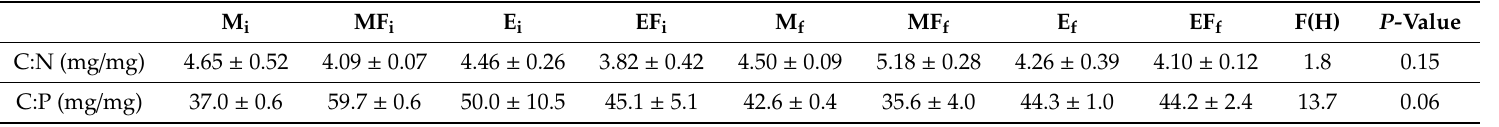
Table 5. Results of one-way ANOVA comparing mean values ( ± SE) of ratios of indicators of nutritive quality of zooplankton in experimental mesocosms: E—eutrophic, LE—low-eutrophic, F—fish, i—initial (June) date, f—final (July) date, C—organic carbon, N—nitrogen, P —phosphorus, F Fisher’s test, and P significant values are given in bold; means labeled with the same letter are not significantly di ff erent at P < 0.05 after Fisher’s LSD post hoc test (in the absence of normal distribution, the Kruskal–Wallis test was